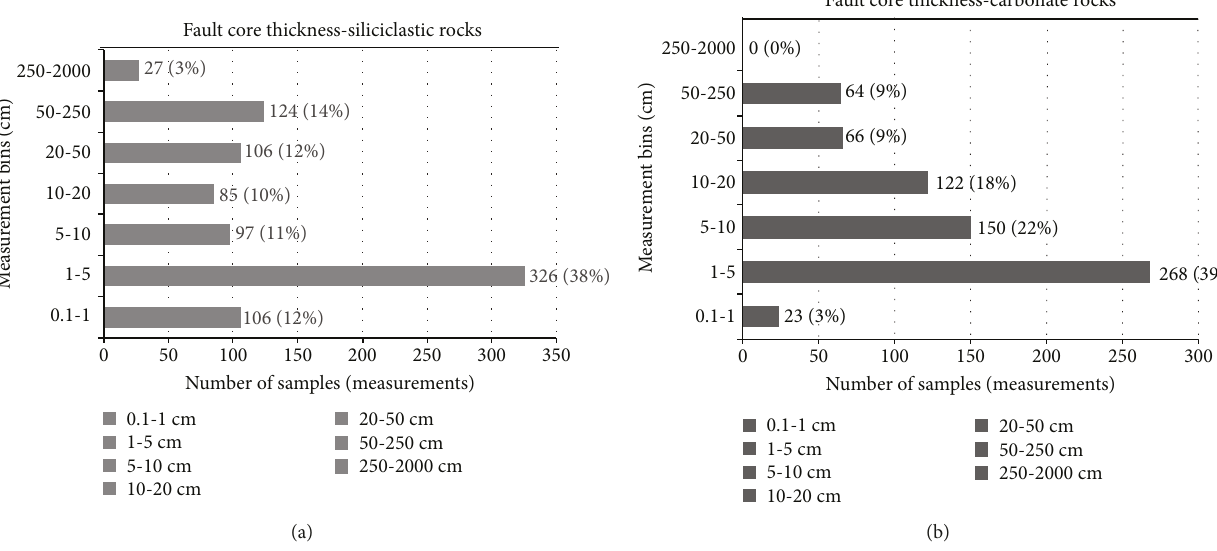
Figure 12: (a, b) Bar diagrams showing the number and percentage of fault core thickness distribution for small faults ( D < 10 m) in siliciclastic and carbonate rocks, respectively.